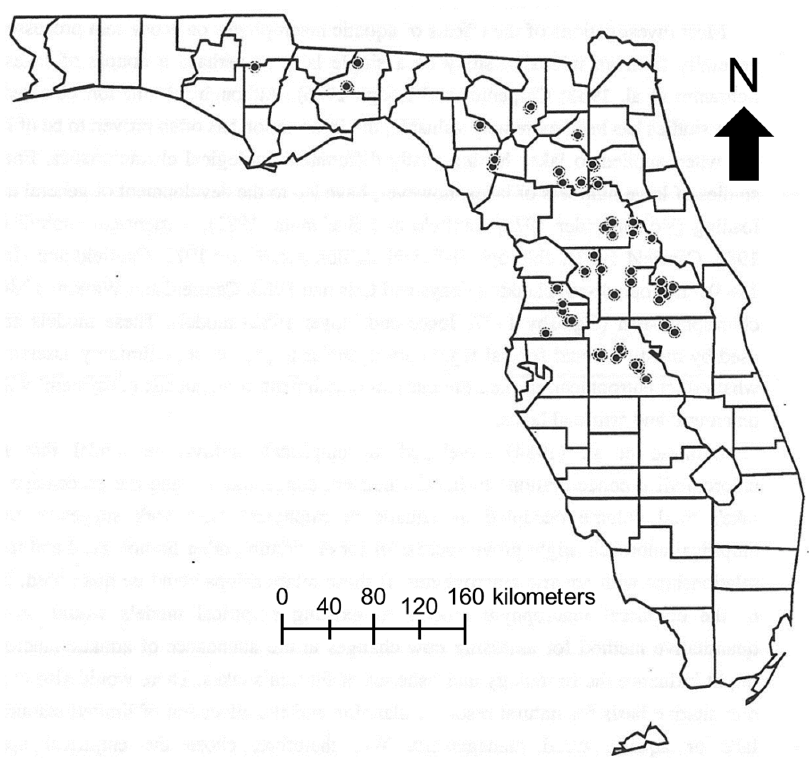
Figure 1. Map of Florida lakes sampled in this study (black circles). Figure modified from [38].